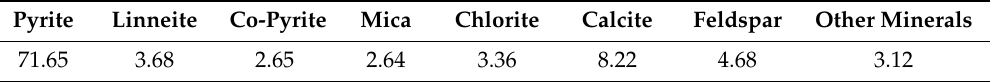
Table 3. Main minerals composition of Co-bearing sulfur concentrate (%).